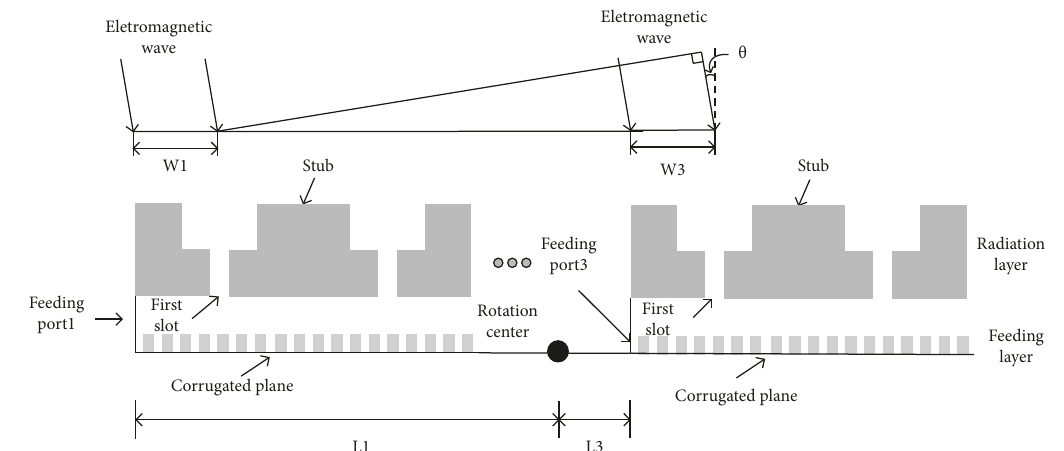
Figure 5: Wavelength difference of two VICTS subarrays on opposite sides of the rotation centre in the y